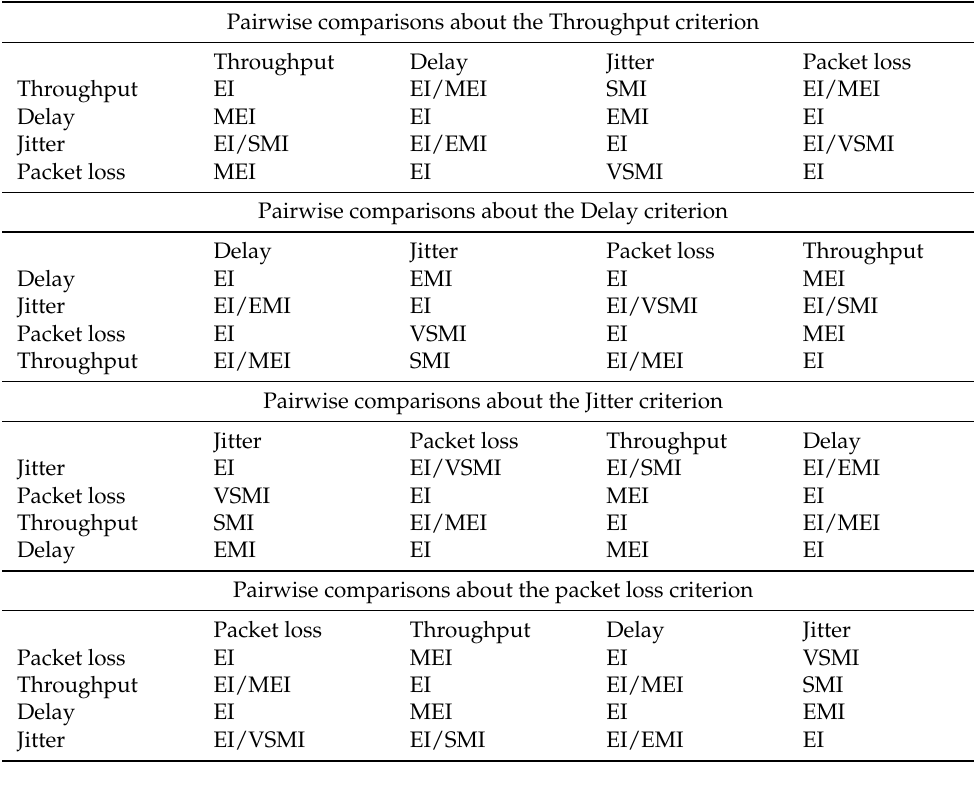
Table 5. The pairwise comparison matrices for the ANav service.